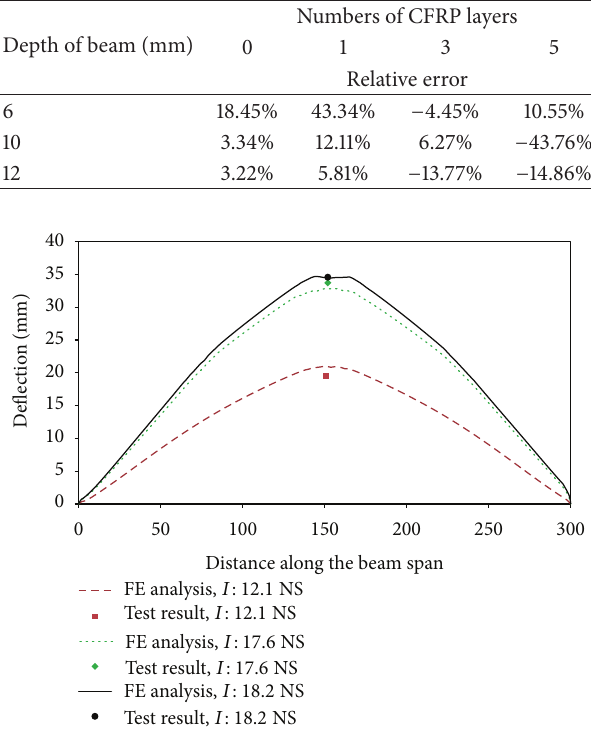
Figure 9: The distribution of deflection along the beam span for different